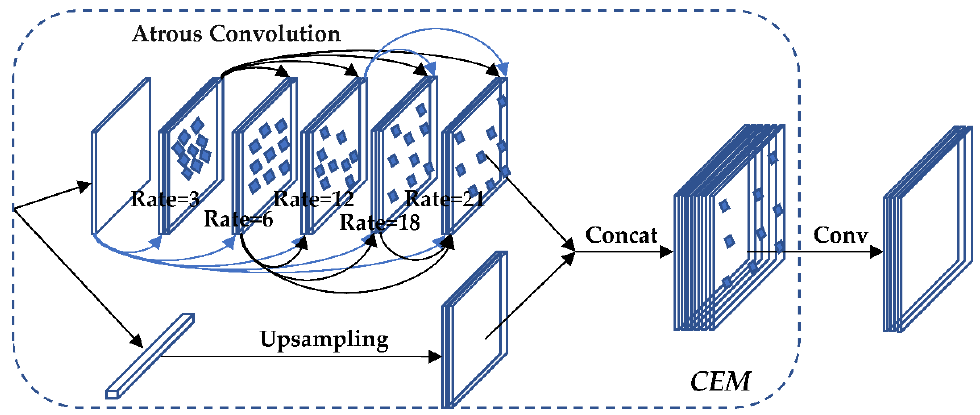
Figure 8. CEM structure diagram.